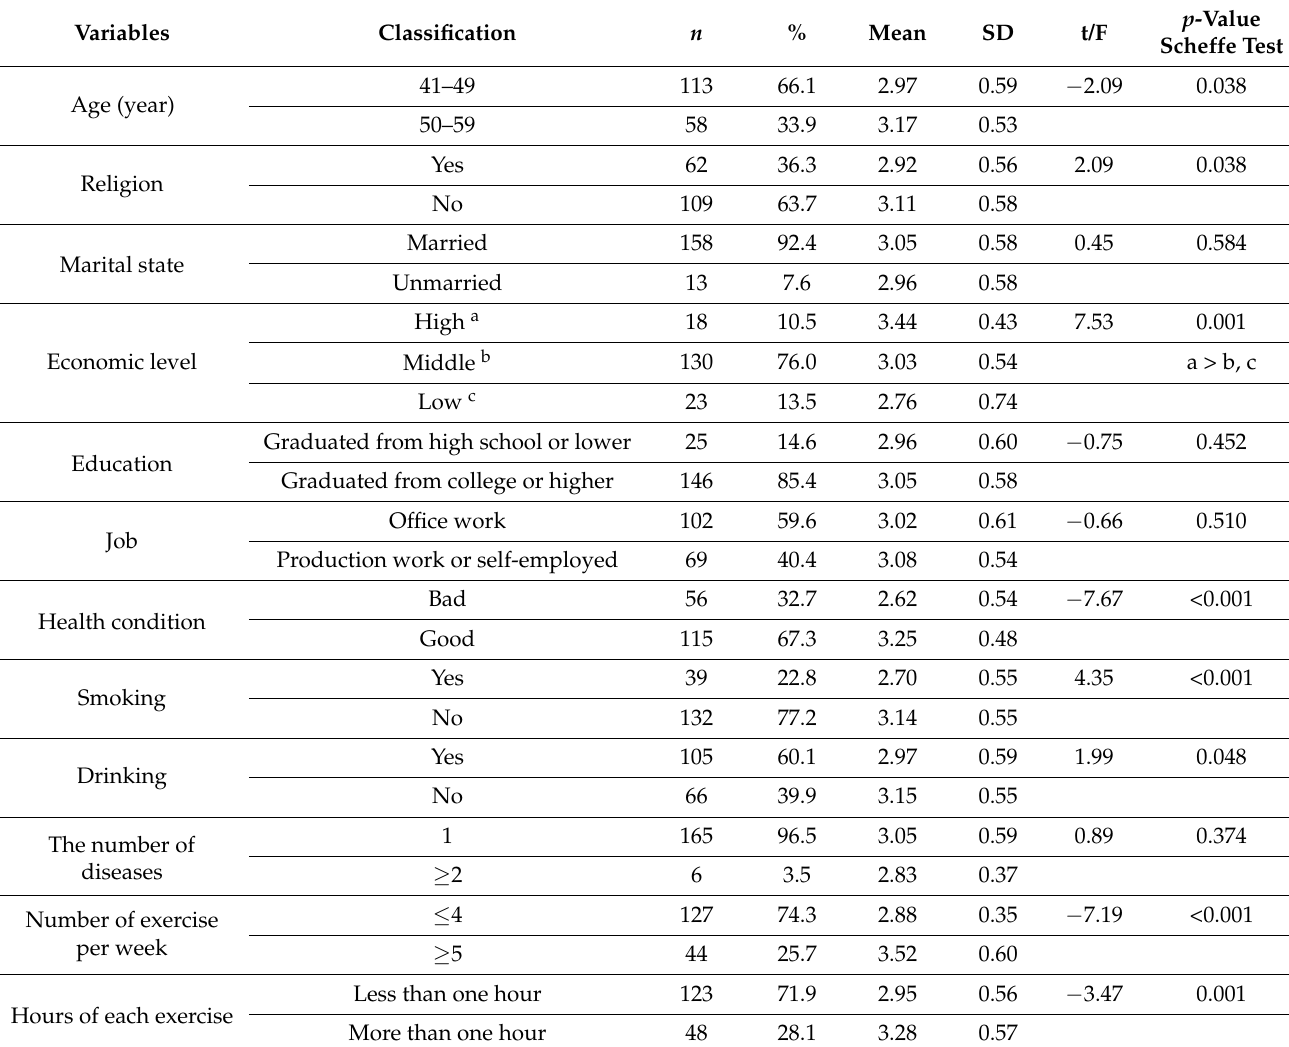
Table 1. Differences in the performance of exercise behavior according to the general characteristics ( N =